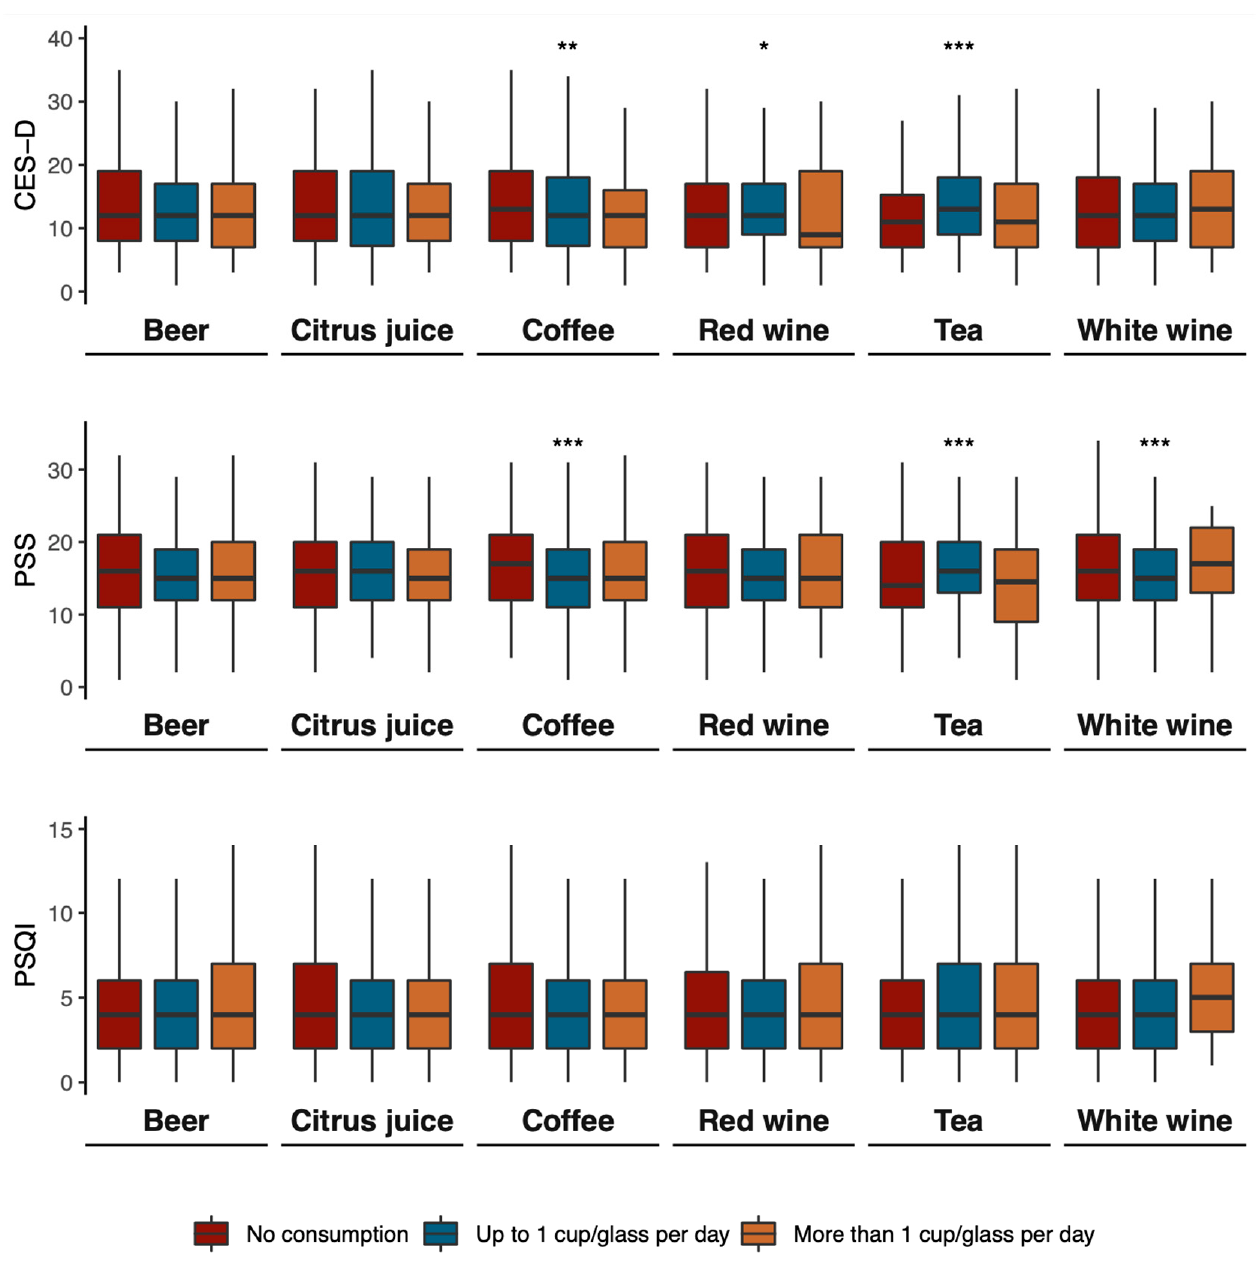
Figure 2. Mean scores of CES-D, PSS, and PSQI by consumption of polyphenol-rich beverages. * p < 0.05; ** p = 0.001; *** p < 0.001.